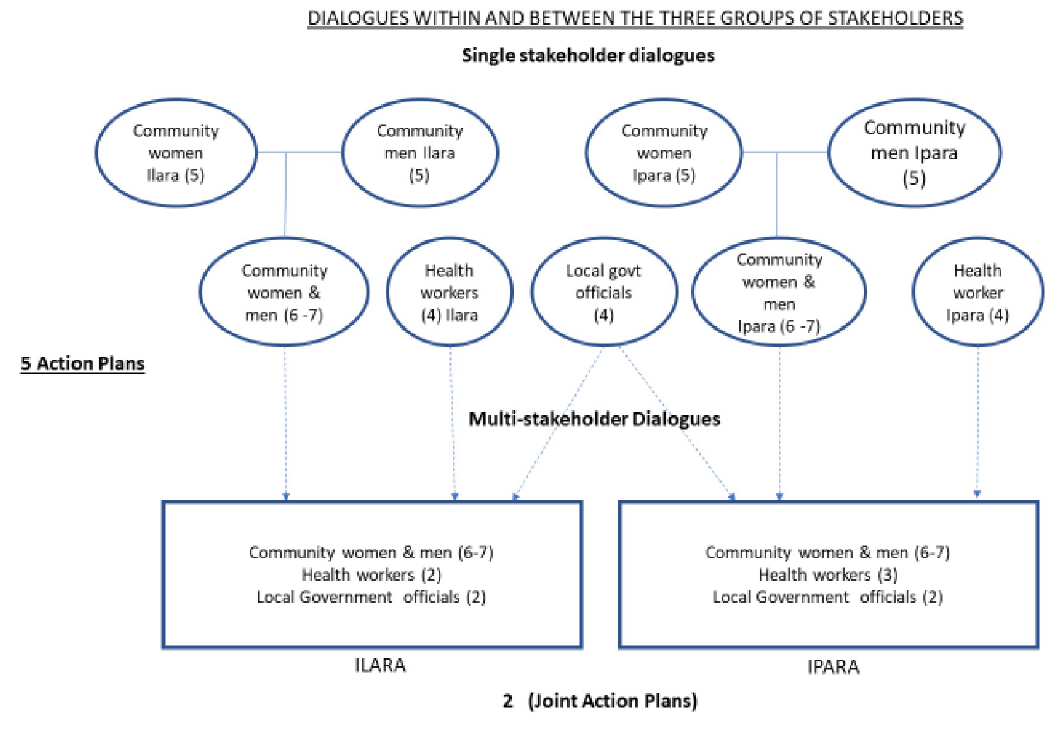
Fig 1. Single and multi-stakeholder